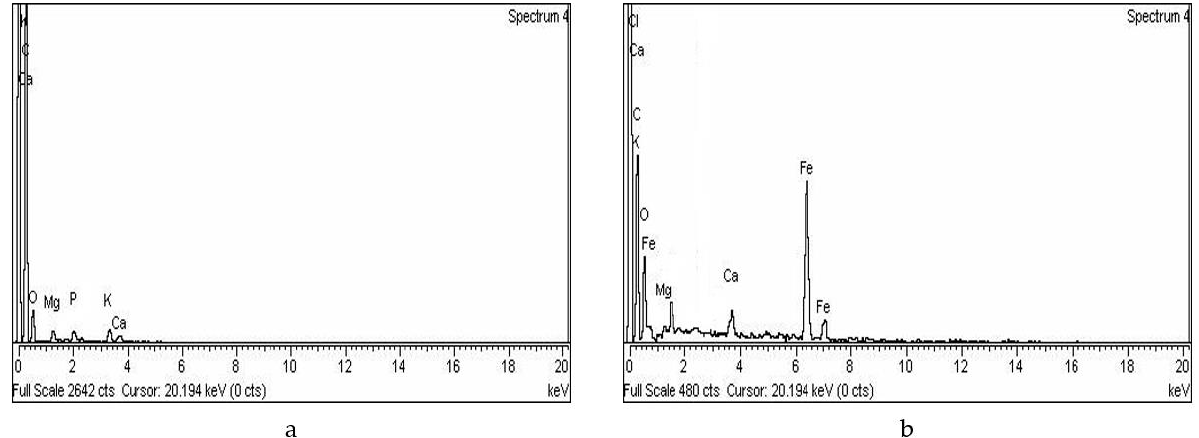
Figure 3. EDX spectra of ( a ) AC ( b ) MAC.